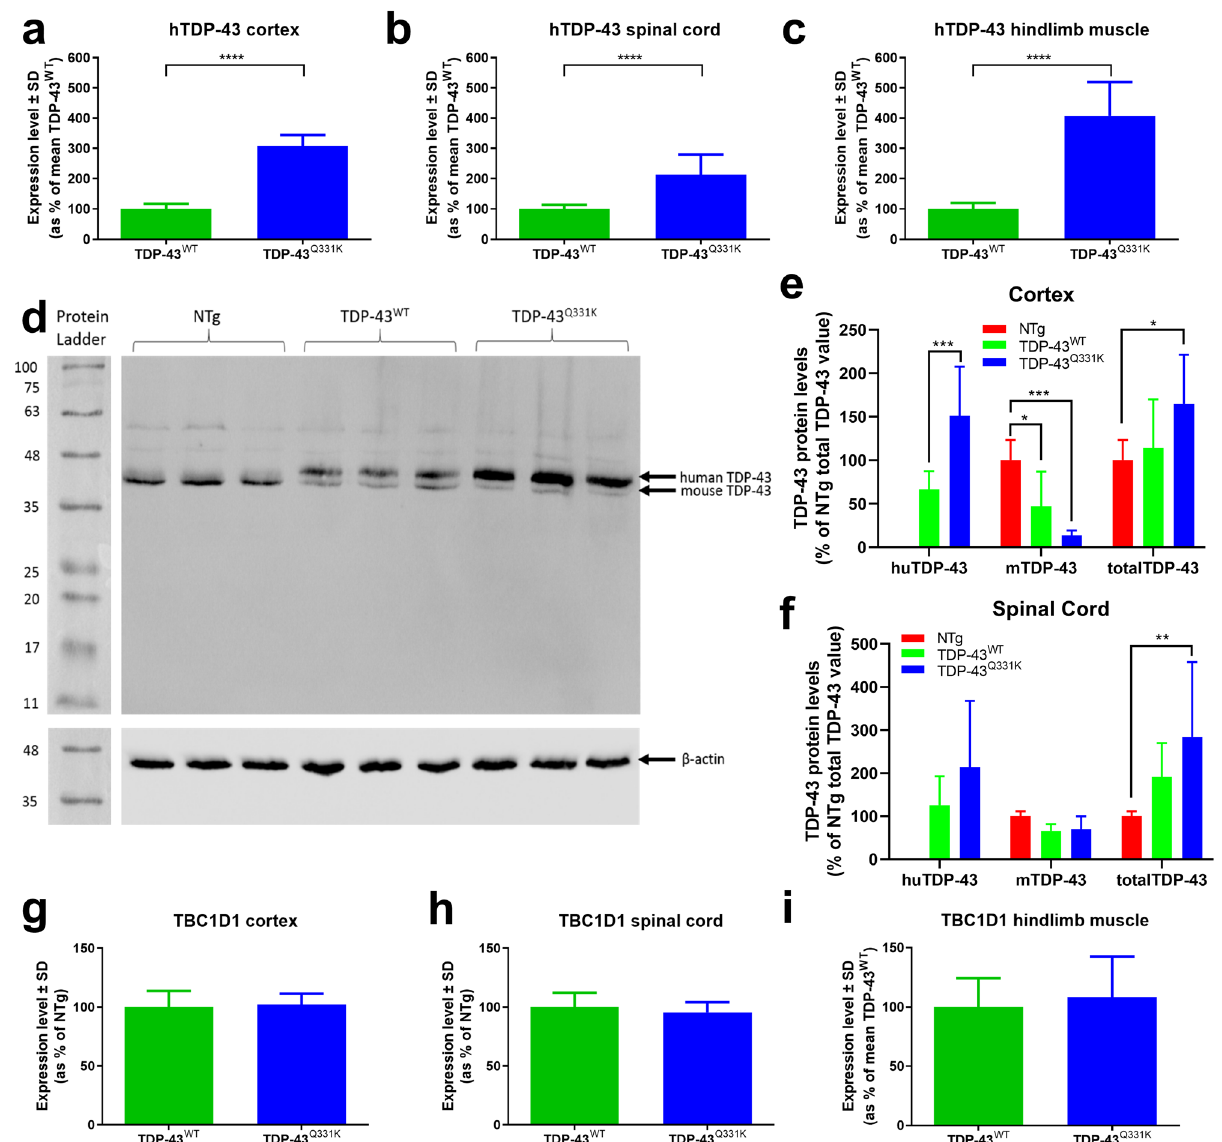
Figure 4. hTDP-43 expression, hTDP-43 and mTDP-43 protein quantification, Tbc1d1 expression. ( A – C ) RT-qPCR for hTARDBP expression in TDP-43 Q331K mice as a percentage of the mean TDP-43 WT in cortex ( A ), spinal cord ( B ) and hindlimb muscles ( C ). **** p < 0.0001, Student’s t test. ( D ) Western blot showed two separate bands for human (44.2kD) and mouse TDP-43 (43kD). This example shows non-transgenic, TDP-43 WT and TDP-43 Q331K 10 month old cortex samples respectively (n = 3, 1 animal per lane). Note the same blot was processed and captured separately for TDP-43 and β-actin staining and these images are separated by white lines. Likewise the protein ladder lane was captured separately under normal illumination and aligned with the blot image. (E–F) Relative human, mouse and total TDP-43 protein levels in 10 m non-transgenic (n = 10 males, 9 females), TDP-43 WT (n = 5 males, 5 females) and TDP-43 Q331K (n = 4 males, 5 females) mice in cortex ( E ), and spinal cord ( F ). All samples are normalised to the non-transgenic total TDP-43 value for each Western blot. ( G – I ) Tbc1d1 expression in TDP-43 Q331K mice (n = 4 males, 5 females) as a percentage of the mean TDP-43 WT levels (n = 5 males, 5 females) in cortex ( G ), spinal cord ( H ) and hindlimb muscle ( I ) showed no differences on a student’s t test. All data shown are mean ±